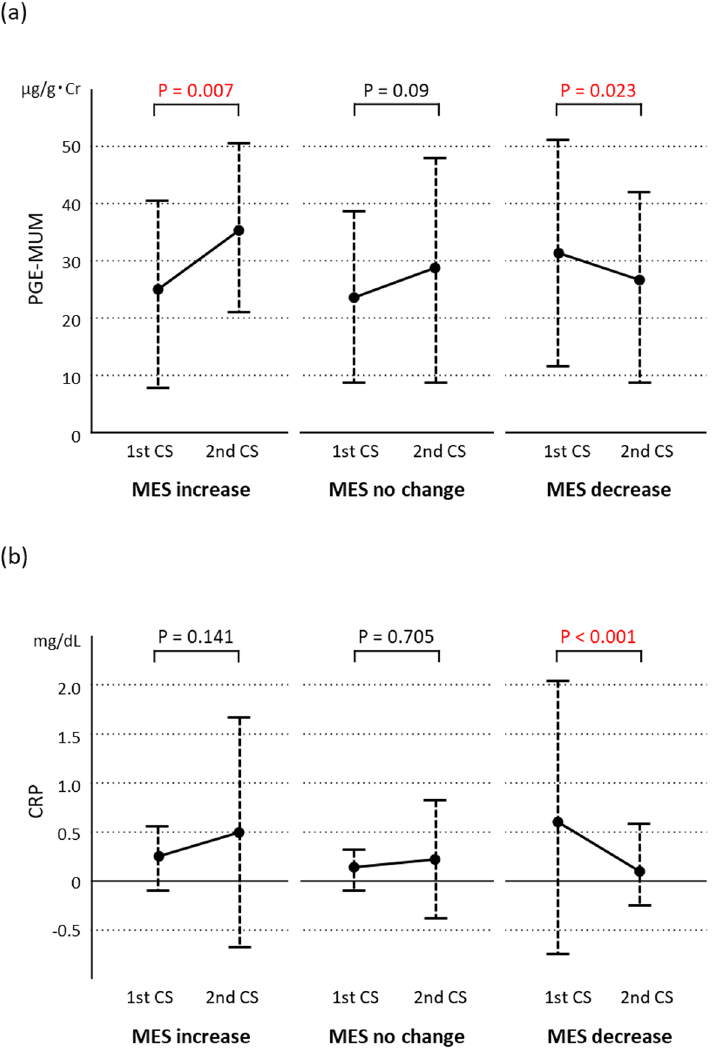
Figure 1. Varying levels of prostaglandin E-major urinary metabolite (PGE-MUM) ( a ) and C-reactive protein (CRP) ( b ) from the precedent colonoscopy (first CS) to the subsequent (second CS) in the Cohort 1 subgroups of Mayo endoscopic subscore (MES) increase, no change, and